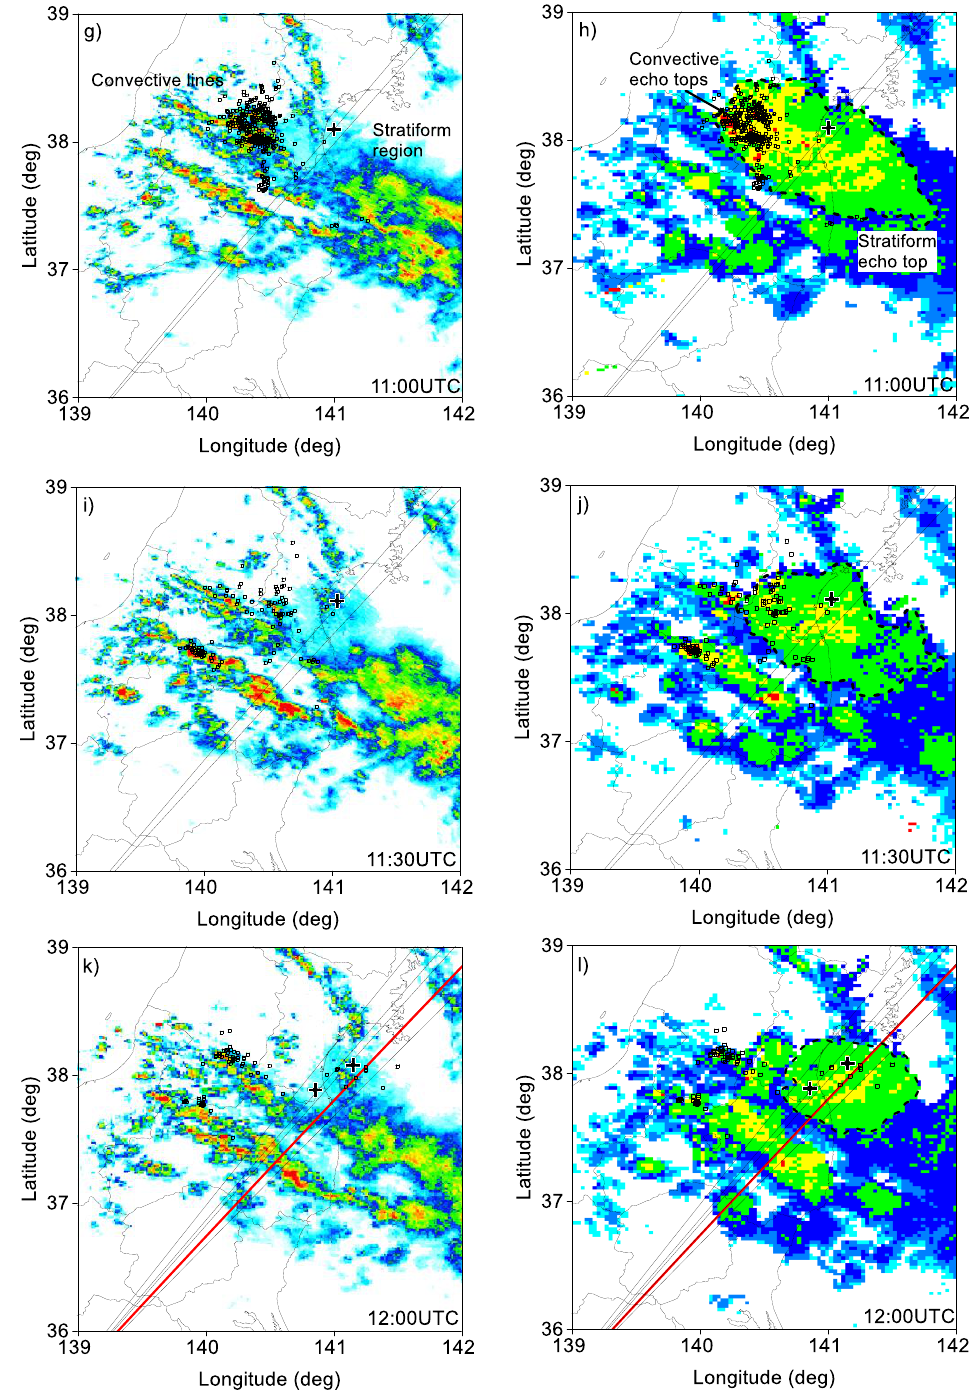
Figure 5. Sprites’ parent MCS and lightning locations. Left panels ( a , c , e , g , i , k ) show precipitation at an altitude of 2 km every 30 min. Right panels ( b , d , f , h , j , l ) show radar echo top height. Open squares show the lightning locations ( ± CGs and intra-cloud lightning locations) during the 30 min period. Plus signs (+) indicate the location of sprite-producing +CGs. The dashed line presents the stratiform echo top at an altitude of roughly 11 km. Arrows indicate clusters of lightning locations in the stratiform region. Arrow heads (triangles and inverted triangles) show lightning locations in the stratiform region. The red lines in k and l indicate the azimuth of Sprite 5, but no CG was detected in association with it.